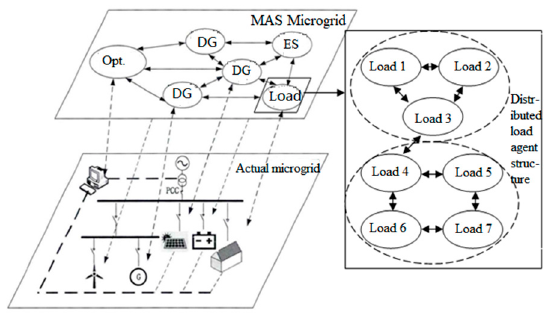
Figure 1. Microgrid and MAS corresponding structure diagram.